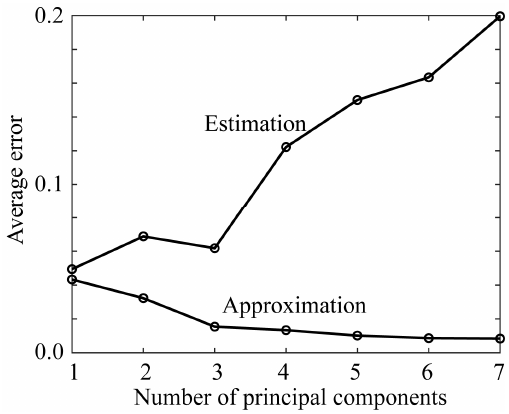
Figure 17. Variations in the estimation error and the approximation error as a function of the number of principal components. The error values are averaged over the four mobile phone cameras.